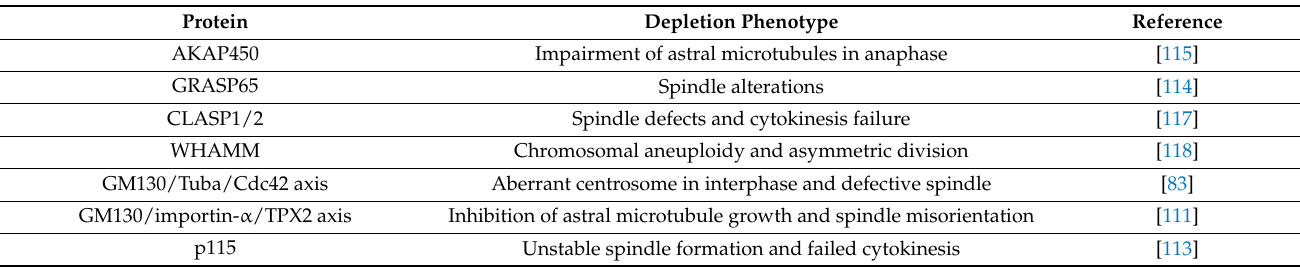
Table 2. Golgi-associated proteins involved in